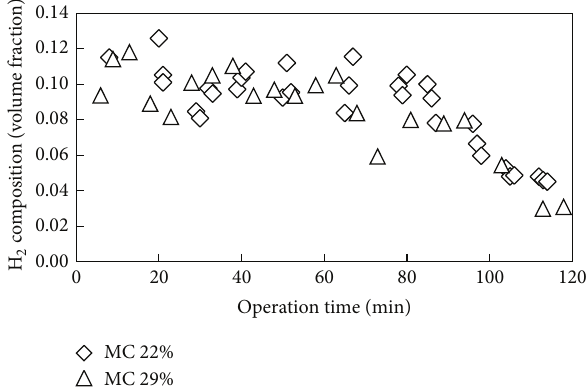
Figure 6: Hydrogen content in syngas over operation time for fuel of different moisture content.